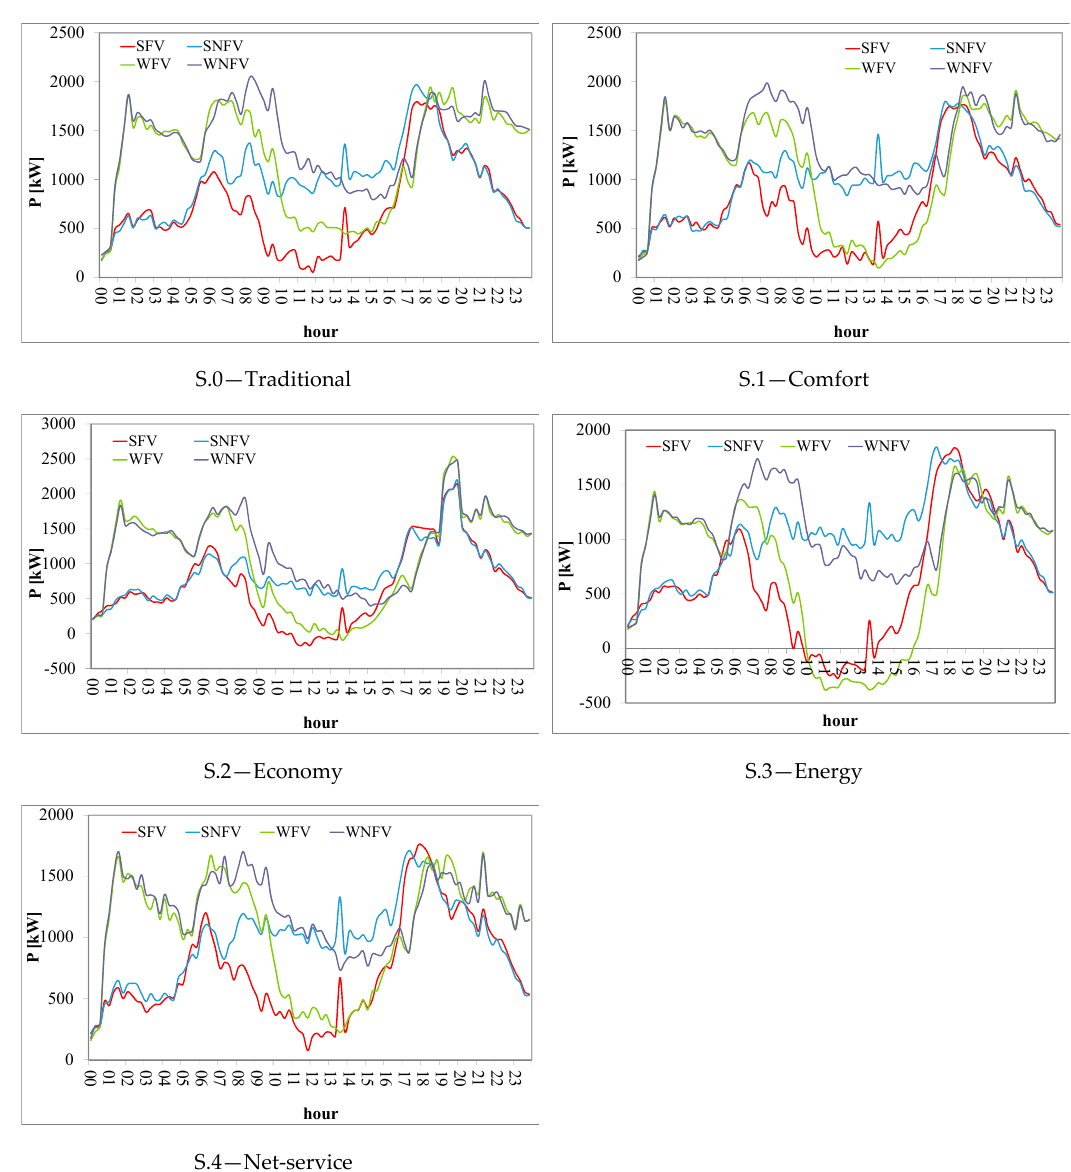
Figure 5. Palermo: daily power profile at a primary substation for Scenarios S.0 to S.4. Table 6. Rome: Energy consumptions and losses for the different control logics (No PV).